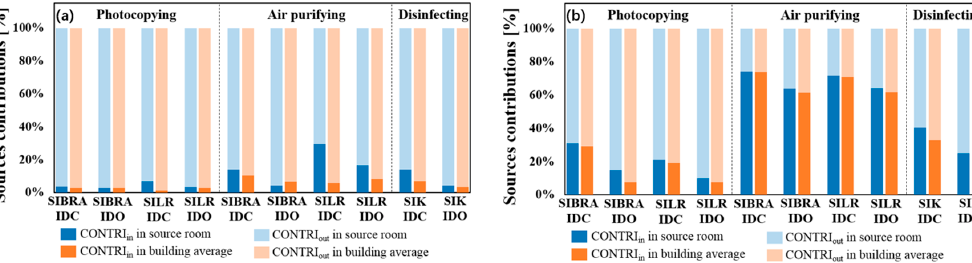
Figure 7. Contributions of indoor and outdoor sources ( a ) in summer, ( b ) in winter. SIBRA, SILR and SIK refer to sources that are located in Bedroom A, the living room, and the kitchen, respectively. CONTRI in and CONTRI out refer to indoor and outdoor sources